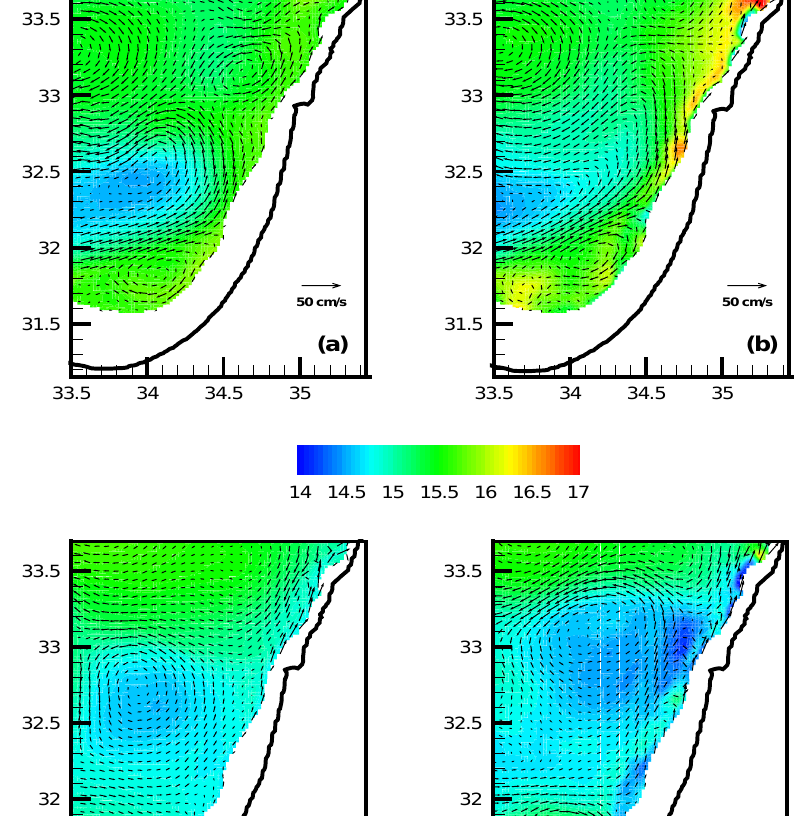
Fig. 11. Simulated potential tempera- ture and velocity at 300m: ( ¯a) 10-day average for 10–20 August of the third year, and (b) 10-day average for 10– 20 August from the intermediate model.